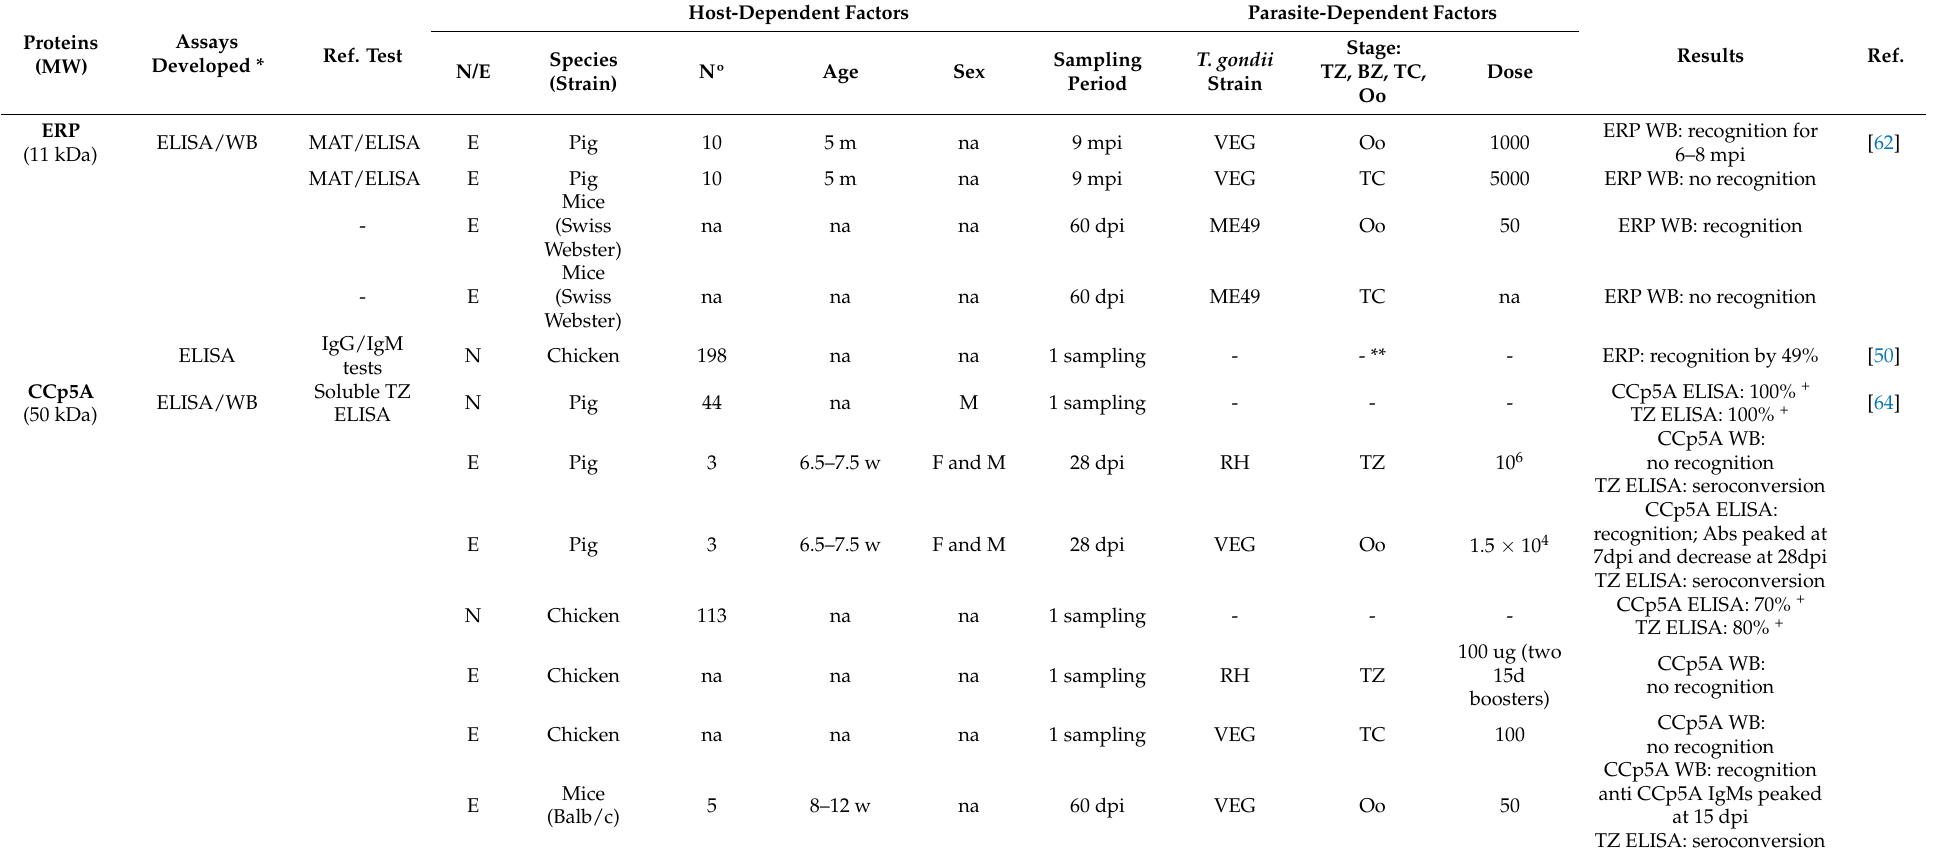
Table 3. Sporozoite recombinant protein-based serological tests developed to differentiate oocyst-driven infections from tissue cyst-driven infections in animals.